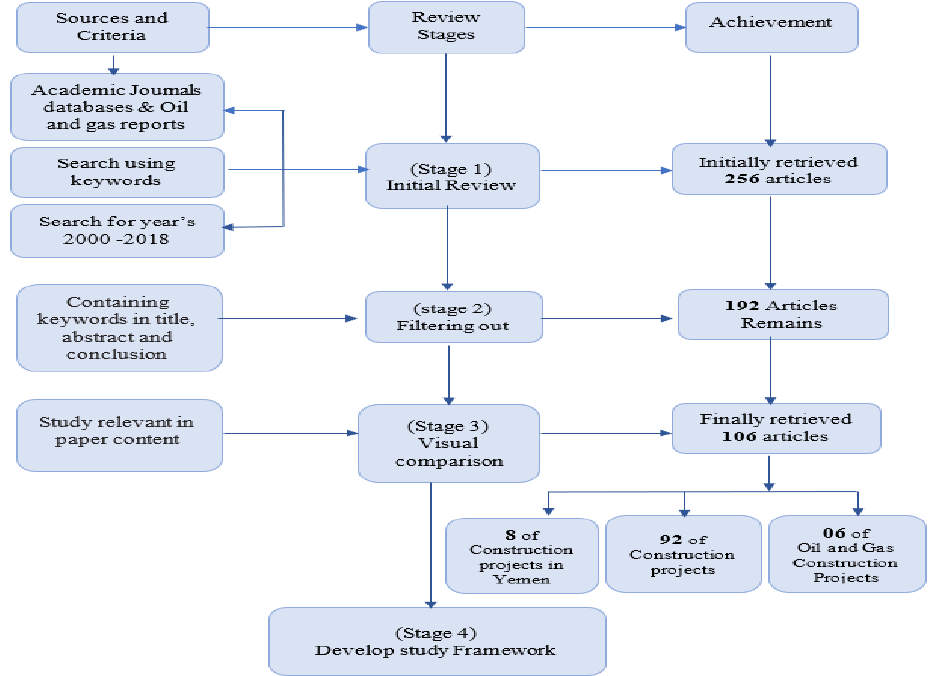
Figure 1. Taxonomy of literature review.